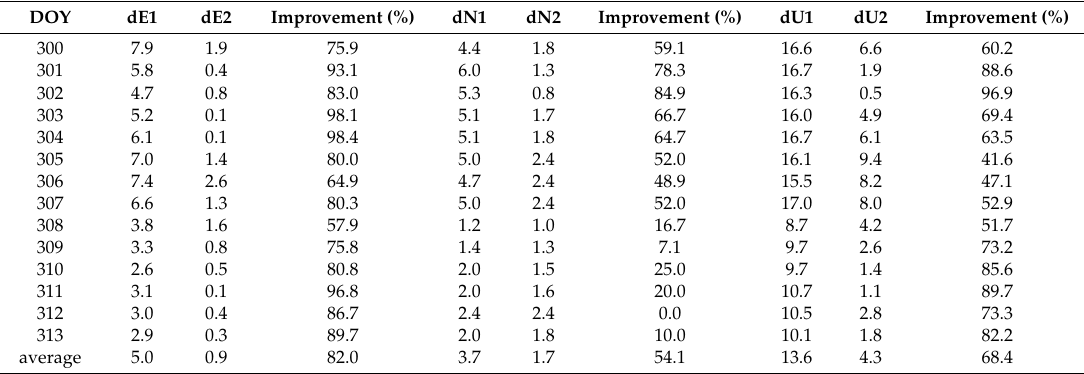
Table 9. Comparison of BDS and GPS static baseline solutions before and after using the new model (unit: mm). dE1, dN1 and dU1 represent the original difference between BDS and GPS static baseline solutions. dE2, dN2 and dU2 represent the new difference between BDS and GPS static baseline solutions using the modified adjustment